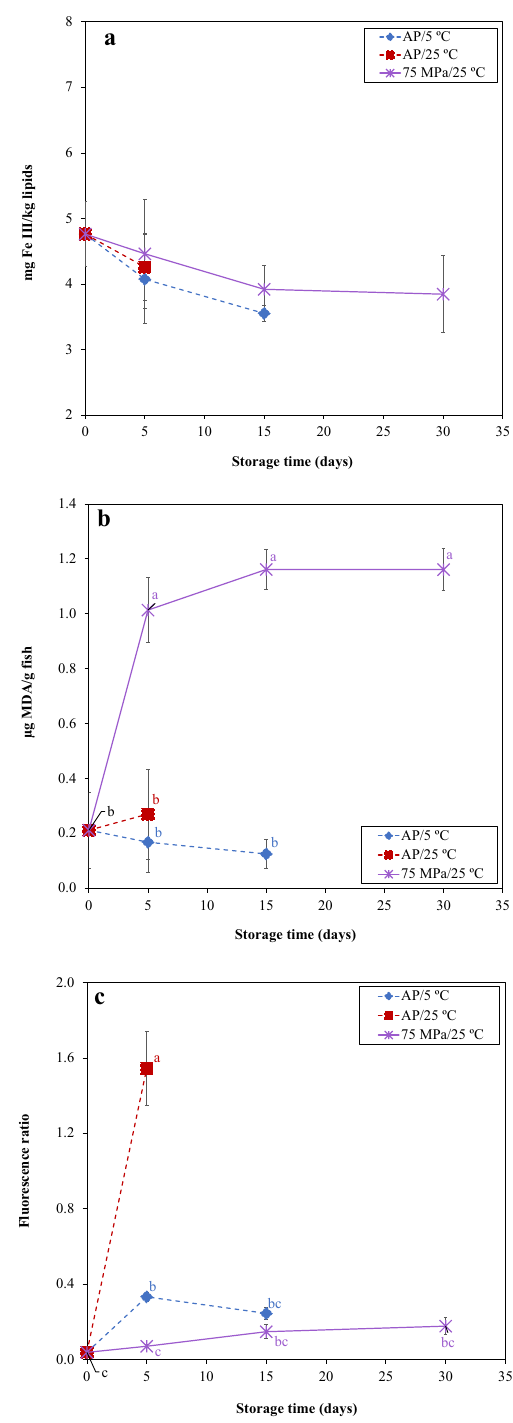
Figure 2. Primary lipid oxidation ( a ; peroxide values in mg Fe III/kg lipids), secondary lipid oxidation ( b ; TBARS in µg MDA/g fish) and tertiary lipid oxidation ( c ; fluorescent compounds in fluorescence ratio) of Atlantic salmon stored at 75 MPa/25 °C, AP/5 °C and AP/25 °C during 30, 15 and 5 days, respectively. Different letters denote significant differences (p < 0.05) between salmon samples stored at different conditions and time ( a – c ). For primary lipid oxidation ( a ) no significant differences were observed in all